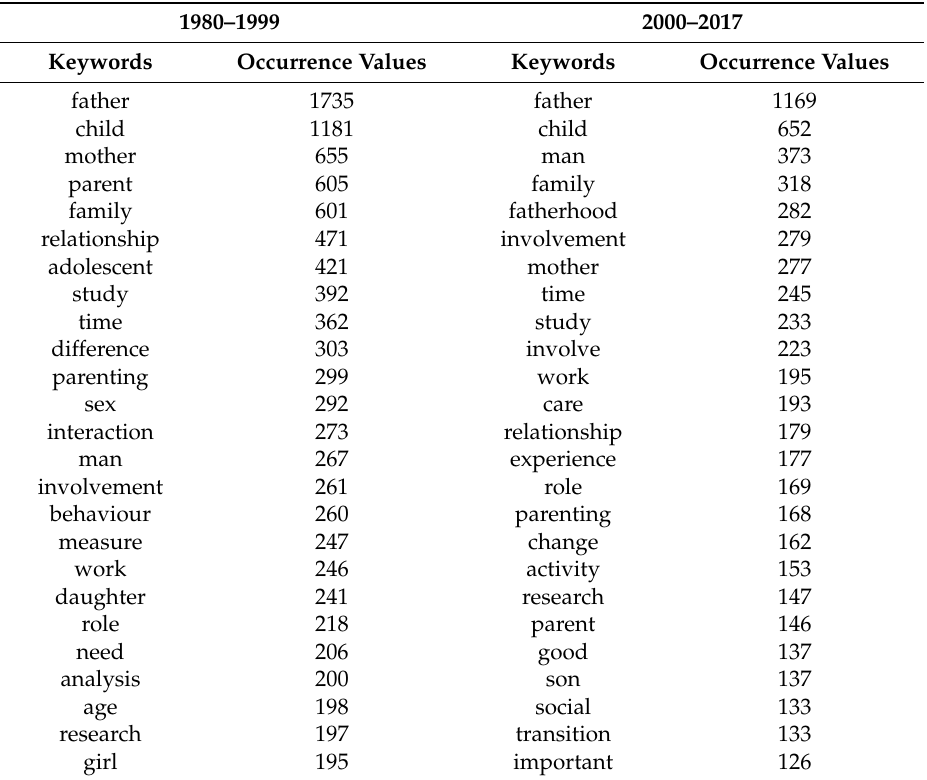
Table 1. Keywordswithrelativeoccurrencevalues: